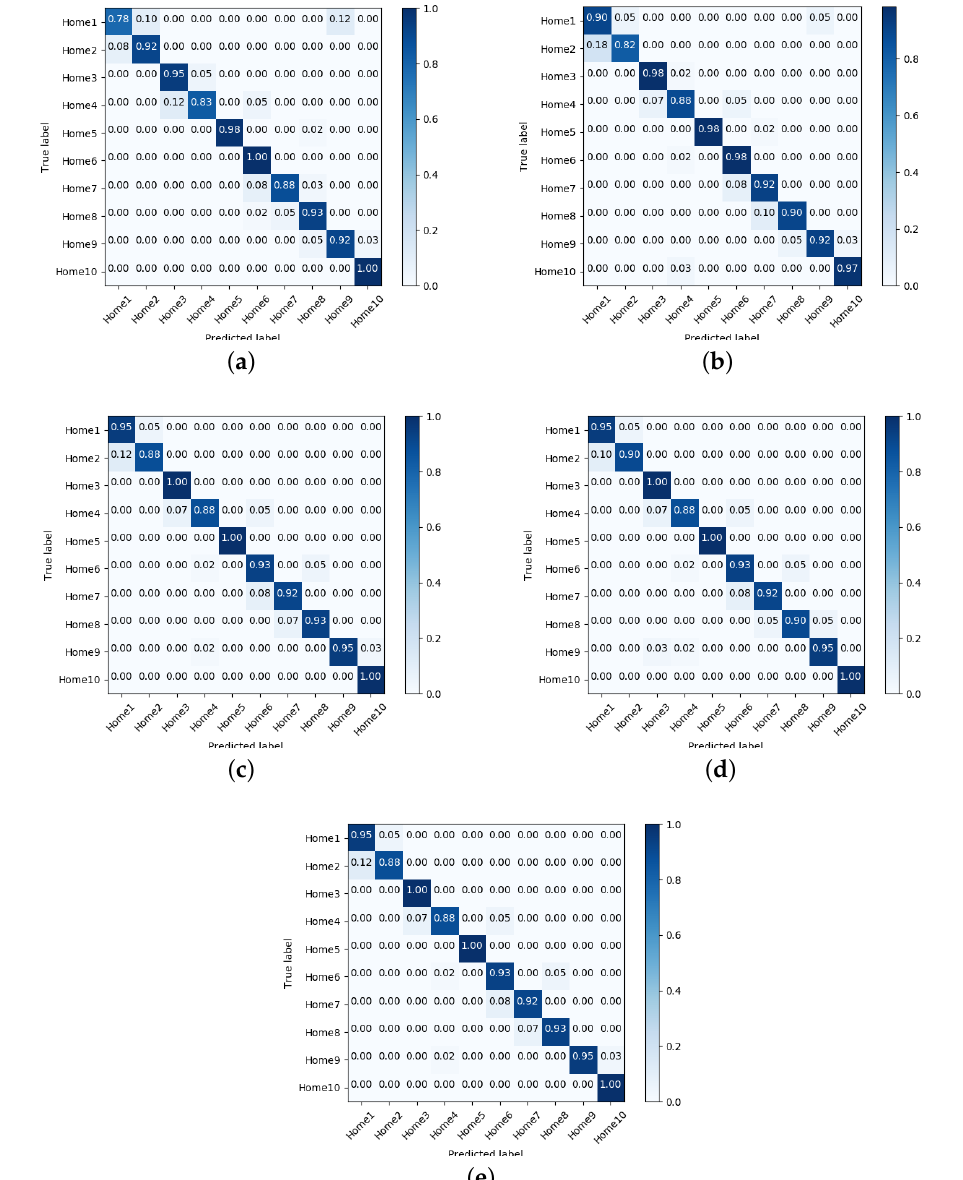
Figure 4. Confusion Matrices for the top-five classifier in Phase 1. ( a ) NNge; ( b ) Ibk; ( c ) Random Committee; ( d ) Random Forest; ( e ) Random